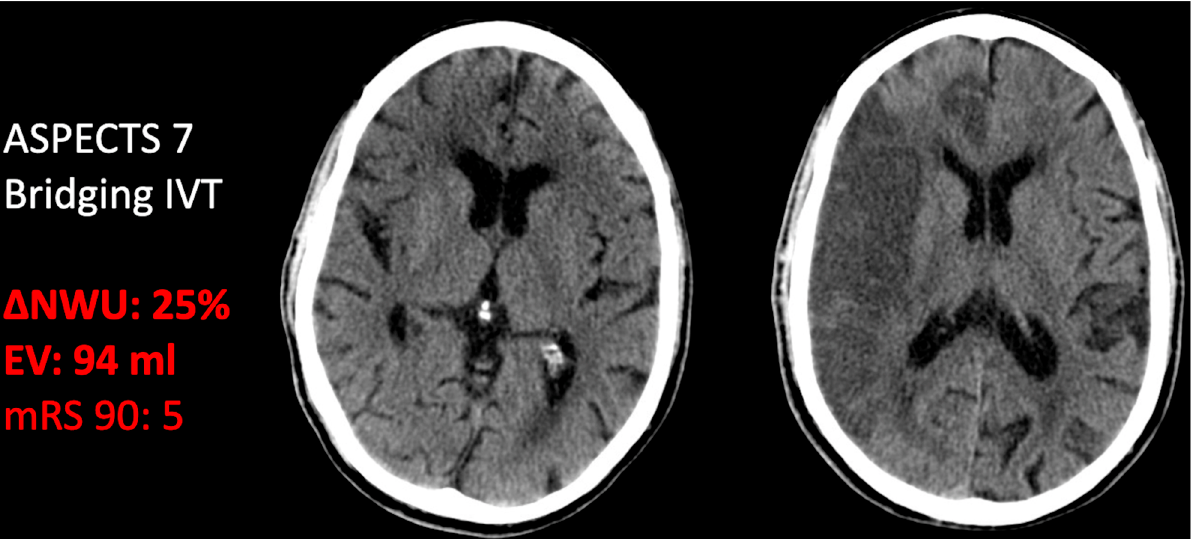
Figure 1. Illustration of a patient receiving bridging intravenous alteplase prior to complete endo- vascular recanalization. The patient showed significant edema progression with aggravated abso- lute edema volume in follow-up imaging. Δ NWU reflects the change of the relative edema propor- tion from admission to follow-up ( Δ NWU = % NWU admission − % NWU follow-up) as previously defined